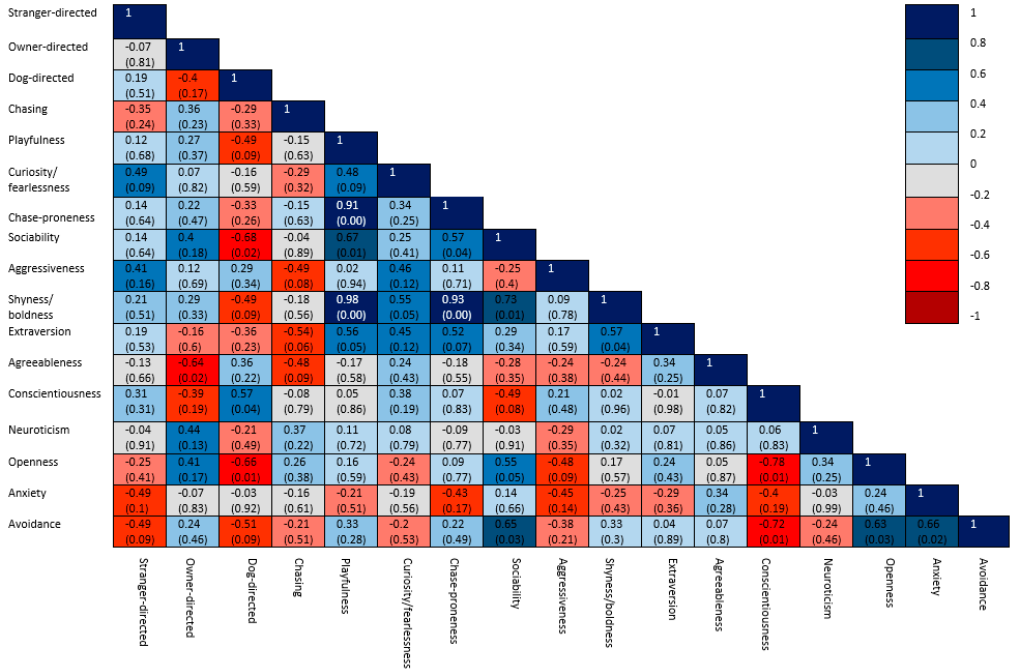
Figure 4. Correlation matrix of the coefficients of the variables in the group of dogs which were aggressive towards humans, with significance levels in brackets.